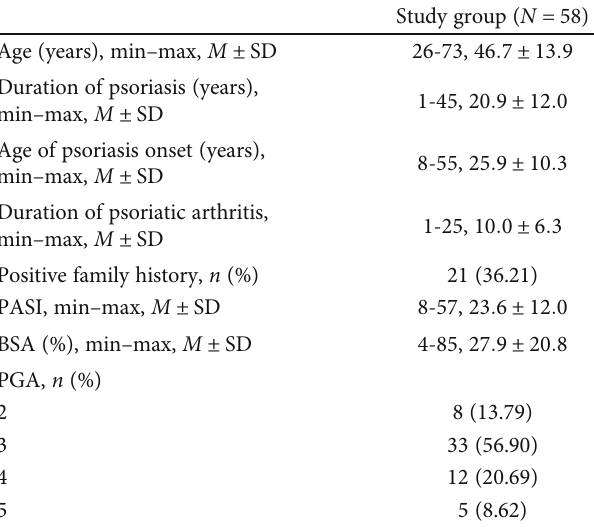
Table 1: Clinical data of psoriatic